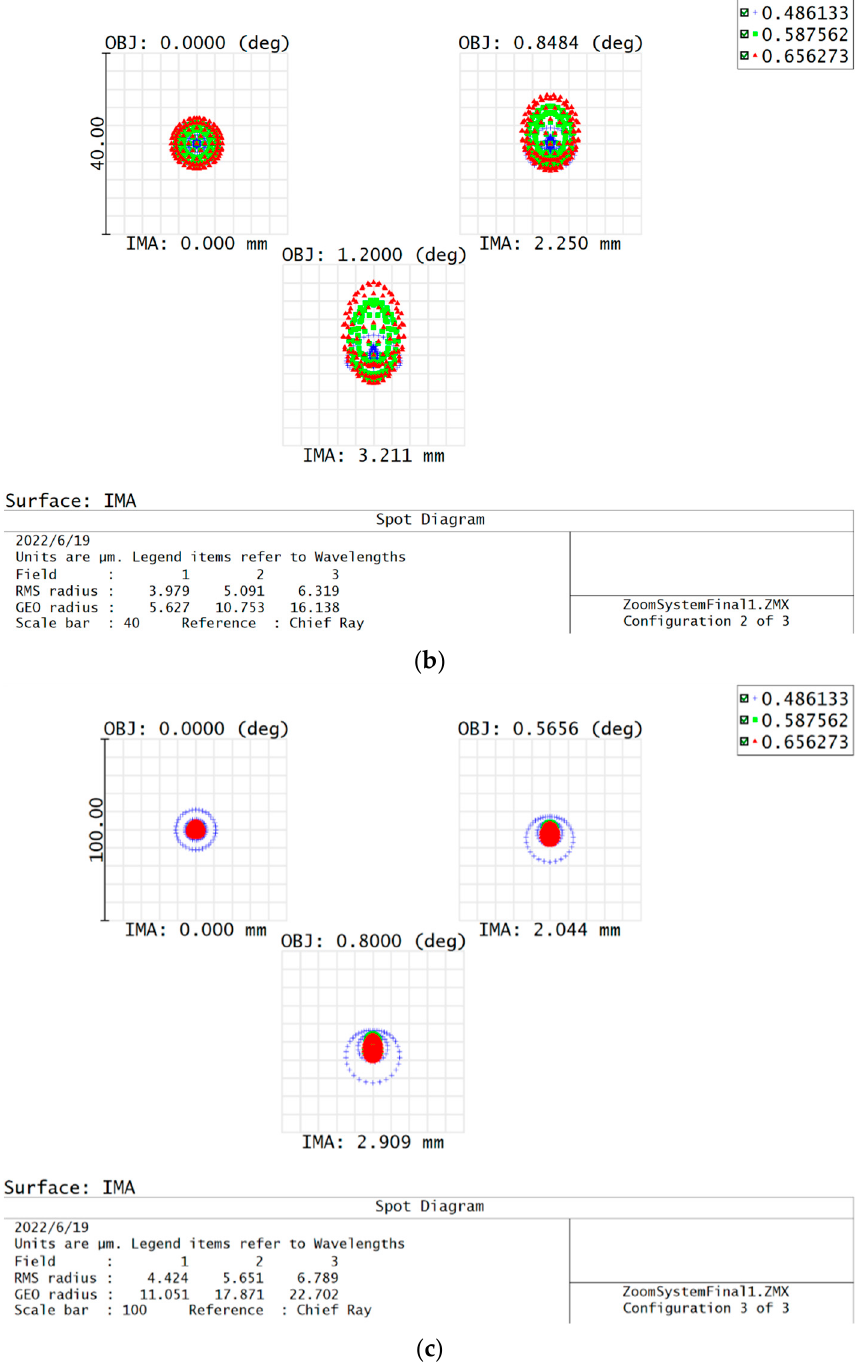
Figure 10. Spot diagrams of the zoom system: ( a ) Focal length of the zoom system is 88.3547 mm; ( b ) Focal length of the zoom system is 150.096 mm; ( c ) Focal length of the zoom system is 204.62 mm.